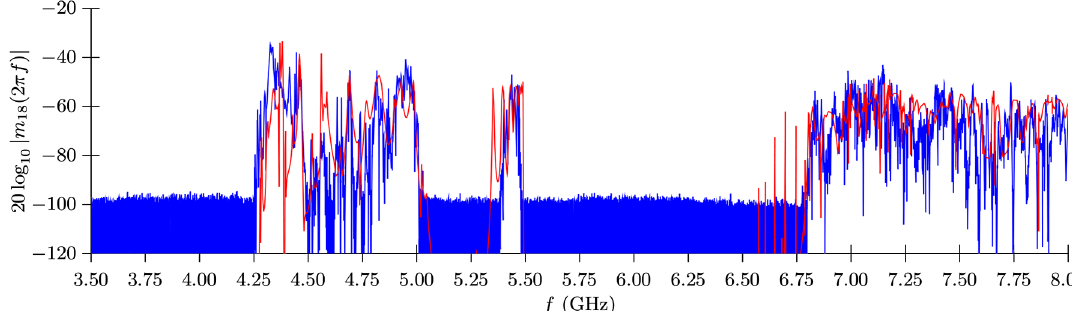
FIG. 15. Absolute value of the transmission spectra via the entire cavity chain (i.e. transmission from coupler C1H2 to C4H2). In accordance to Fig. 14 the fundamental band is also not observable in the spectra because the frequencies of the respective peaks are below the fundamental cutoff frequency f of the beam pipe connecting the adjacent cavities via the co ; TE 11